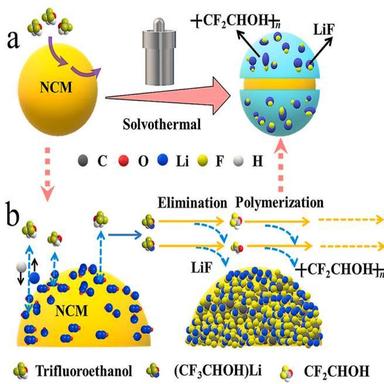
(a) Schematic of the surface modification of NCM by solvothermal treatment; (b) Schematic of the chemical reactions of surface coating at the early stage.